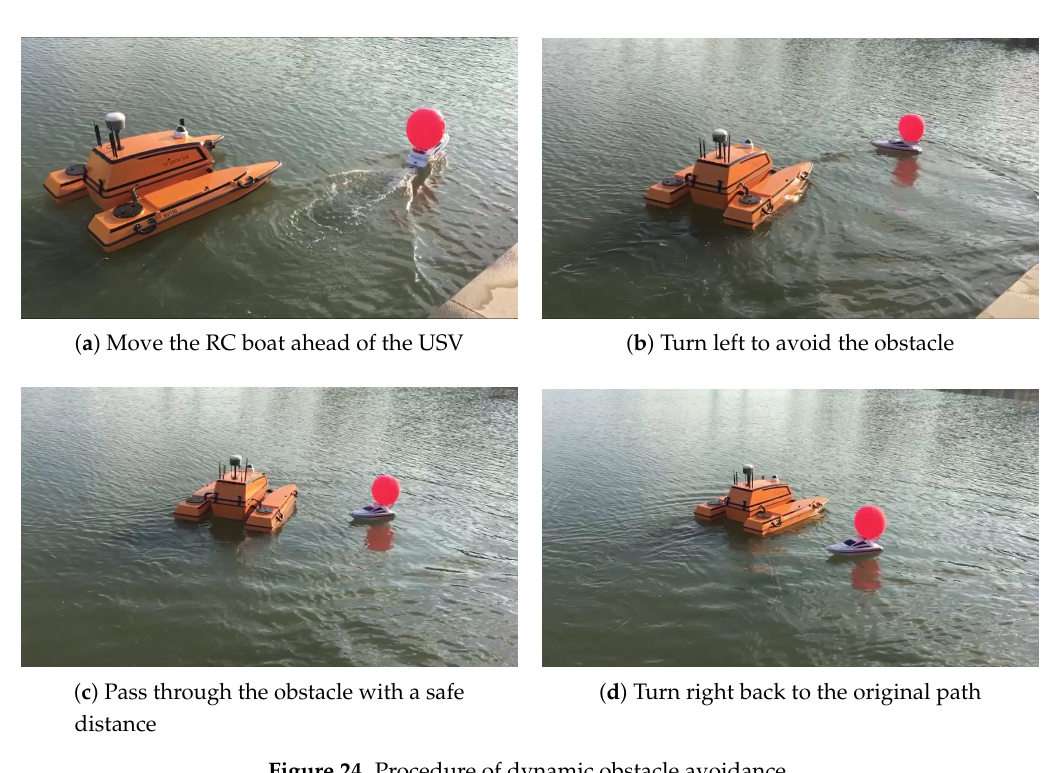
Figure 24. Procedure of dynamic obstacle